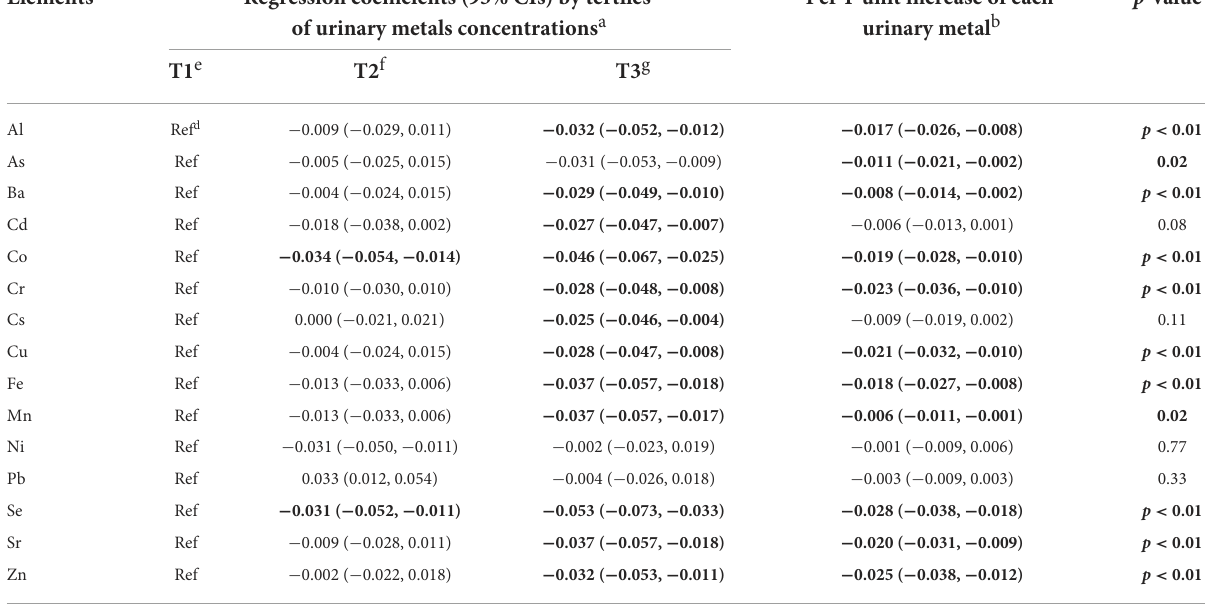
TABLE 3 Associations between urinary elements and serum albumin analyzed by generalized linear regression models. Elements Regression coefficients (95% CIs) by tertiles Per 1-unit increase of each p -value